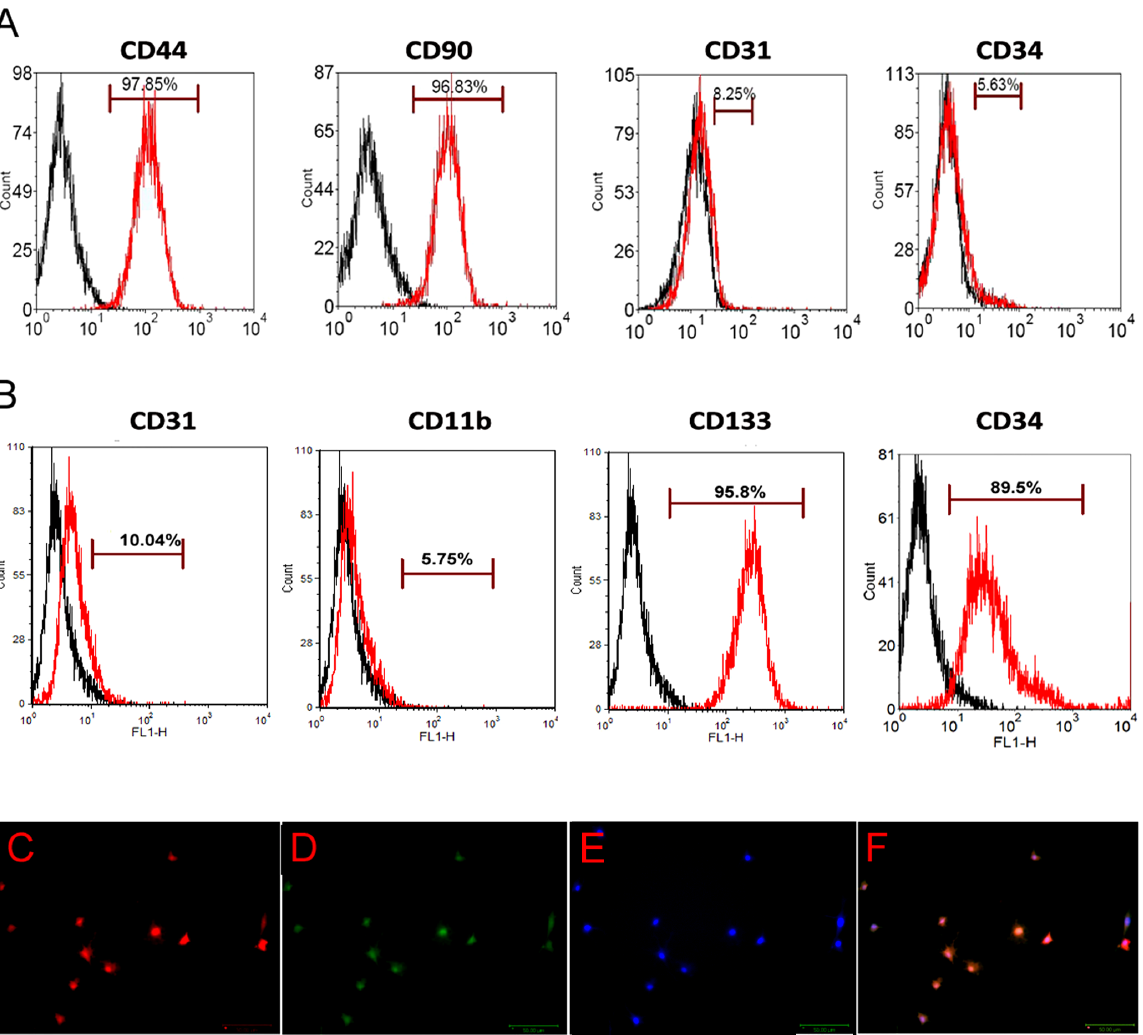
Figure 1. Phenotype identification of MSCs and EPCs. (A) Flow cytometry analysis for MSCs. The red open histograms indicated the cells which were stained positive for the undifferentiated MSCs markers -CD44 and CD90 and negative for CD 31 and CD34. The black open histograms showed isotype-matched control staining. (B) Flow cytometry analysis for EPCs. The red open histograms indicated the cells which were stained positive for the markers of undifferentiated EPCs - CD133 and CD34, and negative for CD31 and CD11b. The black open histograms showed isotope-matched control staining. (C-E) Fluorescence images of EPCs cultured for 14 days and stained with (C) Dil-Ac-LDL, (D) lectin and (E) DAPI. Bar=50 m m. (F) Overlay of images of C, D and